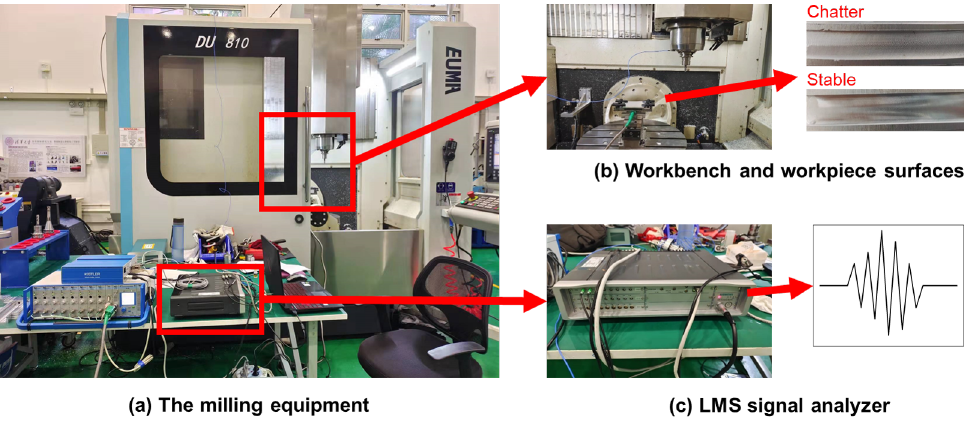
Figure 4. The final assembly of: ( a ) the milling equipment, ( b ) workbench and workpiece surfaces, and ( c ) LMS signal